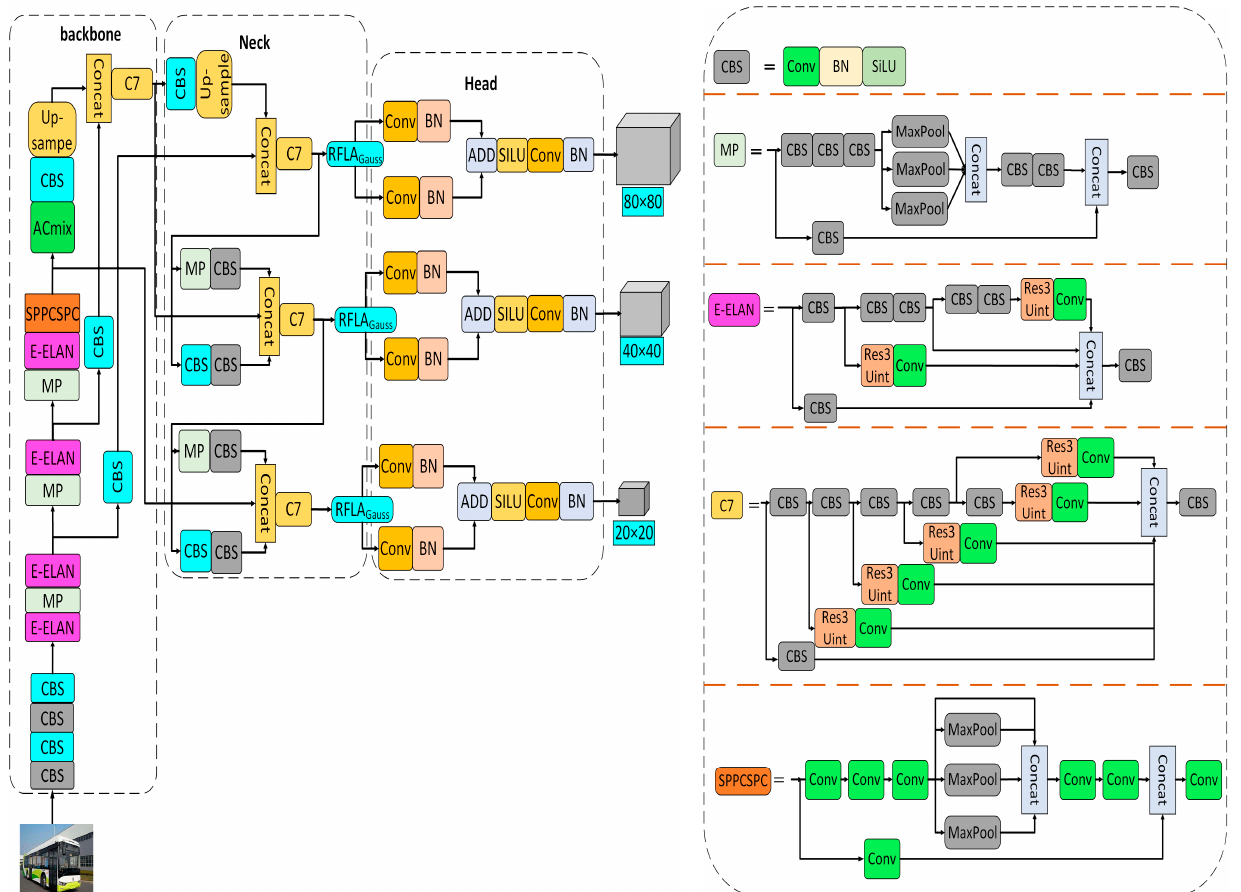
Figure 3. Model structure of the YOLOv7-RAR algorithm.